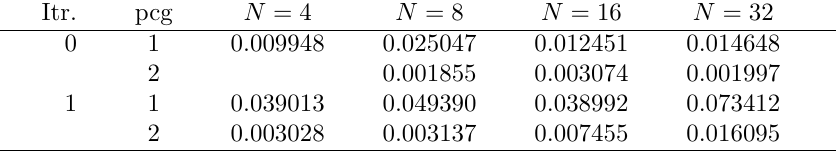
Table 5: The number of PCG iterations and their relative errors (cid:37) end in each Newton step in the very last time level. h,n Itr. pcg N = 4 N = 8 N =